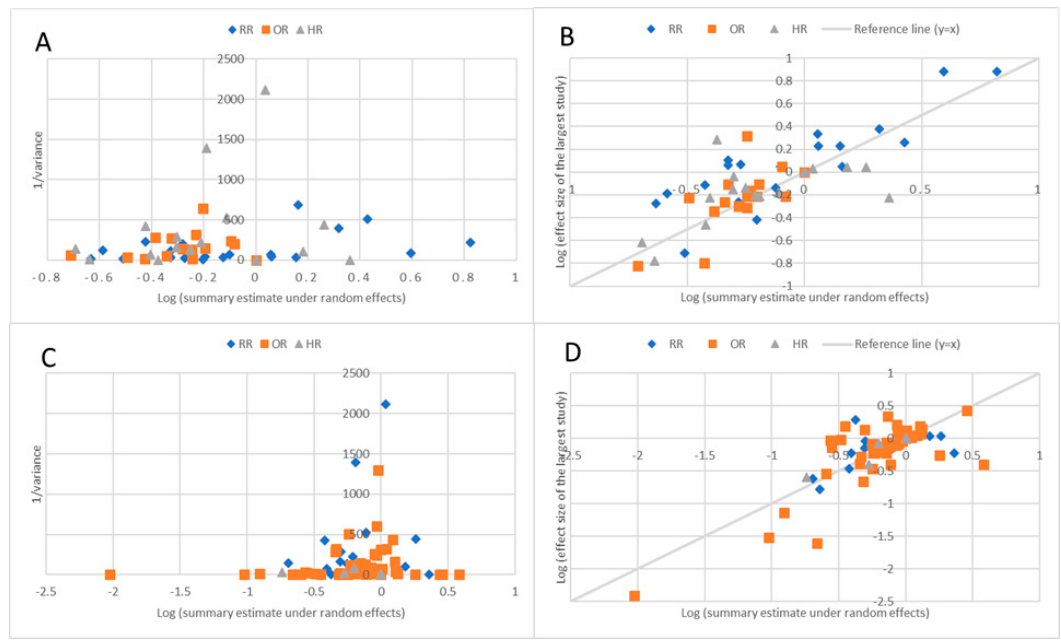
Figure 2. A : Summary estimate of random effects, summary estimate, and inverse variance of meta-analysis of observational studies. The Y-axis labelled “Inverse variance” represents the inverse variance (1/variance) of the random effects’ summary estimate of each meta-analysis. The X-axis labelled “Log (summary estimate under random effects model)” represents the log of the summary estimate under random effects of each meta-analysis, presented. B : Log (effect size of the largest study) versus log (summary effect under random effects) for each meta-analysis of observational studies. The Y-axis labelled “Log (effect size of the largest study)” represents the log of the effect estimate of the largest component study (study with the smallest standard deviation) of each meta-analysis. The X-axis labelled “Log (summary estimate under random effects model)” represents the log of the summary effect estimate under random effects of each meta-analysis. C : Summary estimate of random effects summary estimate and inverse variance of meta-analysis of randomized controlled trials. D : Log (effect size of the largest study) versus log (summary effect under random effects) for each meta-analysis of randomized controlled trials.